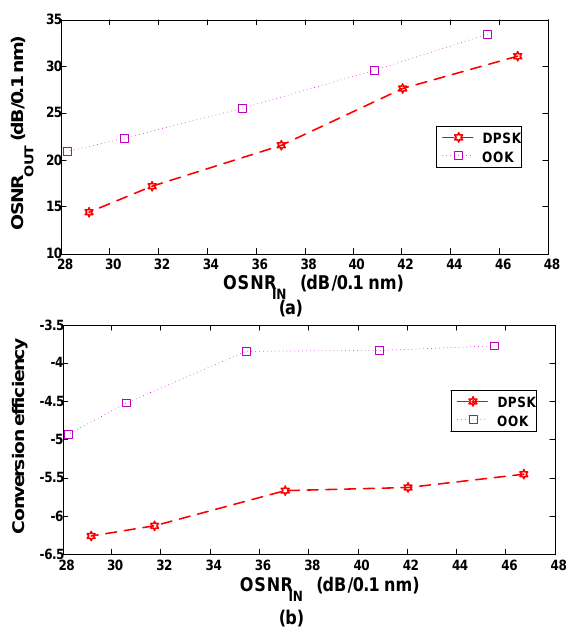
Figure 6. ( a ) Output OSNR vs. input OSNR, and ( b ) conversion efficiency vs. input